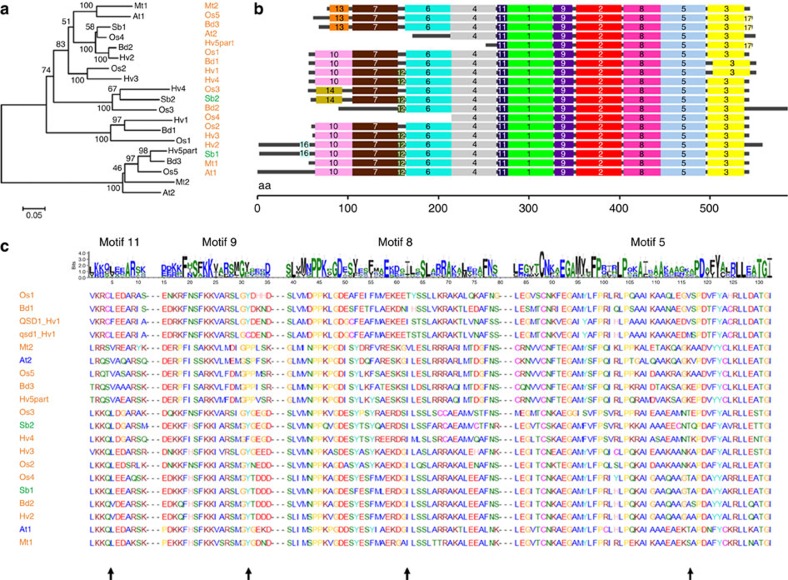
Alignment of QSD1 homologues in plant species.(a) Multiple alignment of QSD1 amino acid sequences (Hv1: Haruna Nijo). Sequences are listed from accessions showing similarity to QSD1 (E-value <E−145) by the blastp analysis in NCBI nr. Species and homologues with accession numbers are Hordeum vulgare: Hv1 (BAK04026.1), Hv2 (BAK07780.1), Hv3 (P52894.1), Hv4 (BAK05632.1), Hv5part (BAJ90574.1); Oryza sativa: Os1 (NP_001063248.1), Os2 (NP_001064504.1) Os3 (NP_001064505.2), Os4 (NP_001060284.1), Os5 (NP_001058716.1): Sorghum bicolor: Sb1 (XP_002463187.1), Sb2 (XP_002467302.1), Brachypodium distachyon: Bd1 (XP_003578159.1), Bd2 (XP_010235387.1), Bd3 (XP_003557680.1), Arabidopsis thaliana: At1 (NP_173173.3), At2 (AAK68842.1), Medicago truncatula: Mt1 (XP_003627448.1), Mt2 (XP_003613139.1). Annotation information is available in Supplementary Table 7. Scale bar indicates Poisson Correction distance. (b) Motif analysis of Qsd1 homologues using SALAD database22. (c) Multiple alignment of motifs which show non-synonymous substitutions between QSD1 (Hv1: Haruna Nijo) and qsd1 (Hv1: H602). Arrows indicate positions of amino-acid substitutions located in motifs 11 (exon9), 9 (exon11), 8 (exon13) and 5 (exon14).